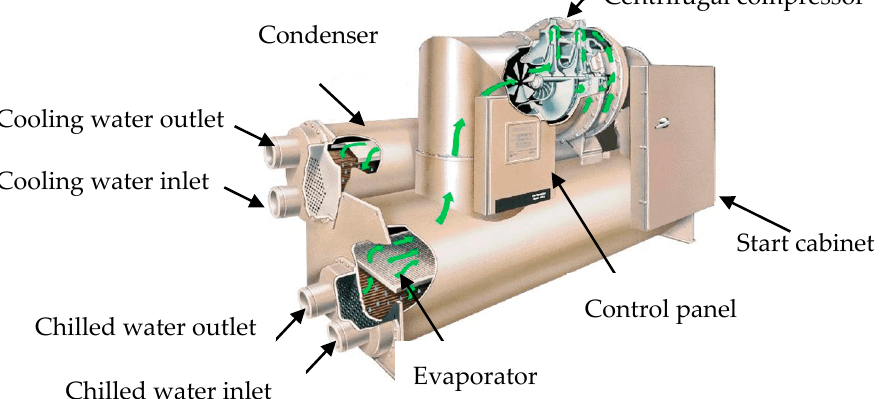
Figure 3. Structure of the centrifugal chiller. Table 1. Summary of chiller faults.